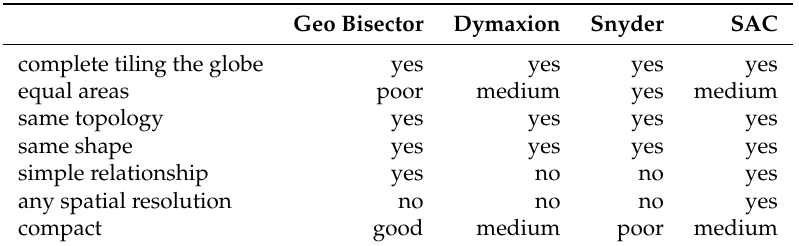
Table 1. Criteria comparison between different